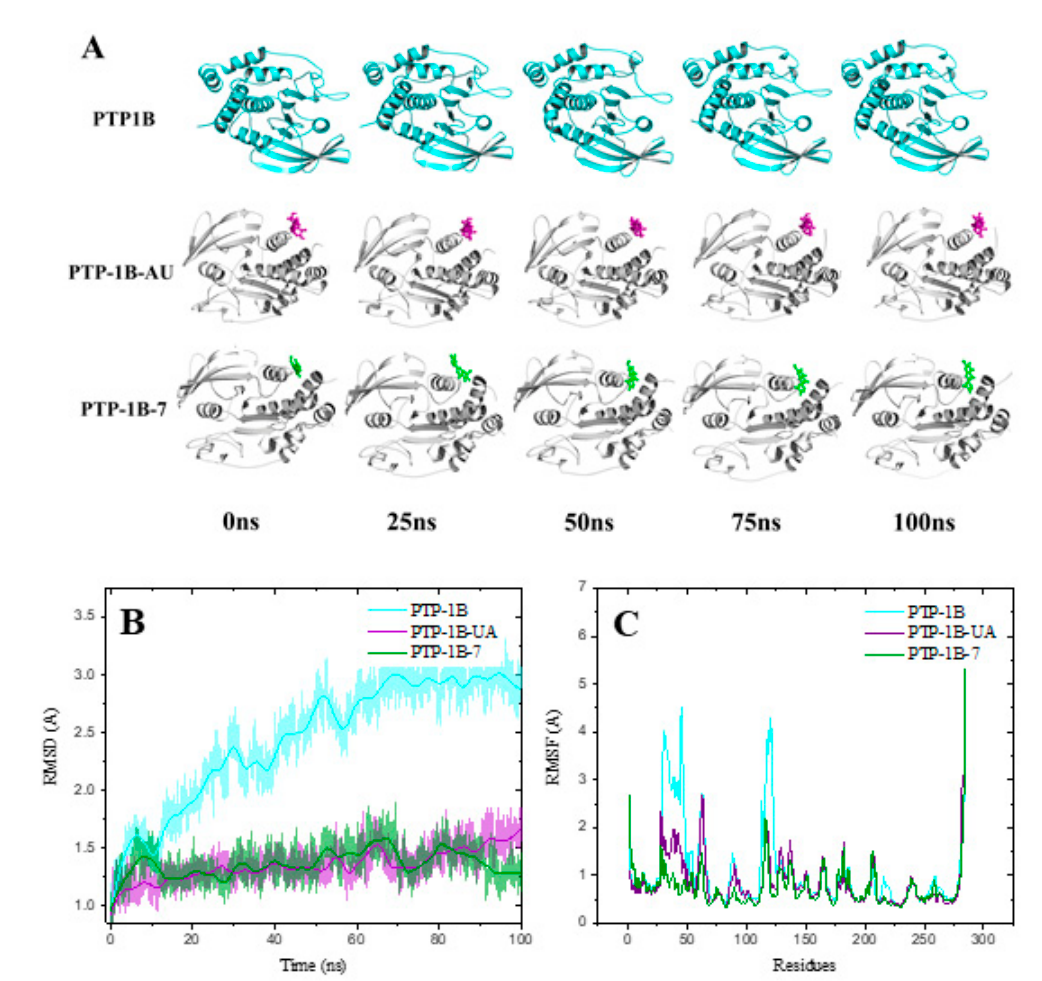
Figure 4. Molecular dynamics at the allosteric site of PTP-1B for compound 7 . ( A ) Structural models, ( B ) RMSD and ( C ) RMSF from molecular trajectories.